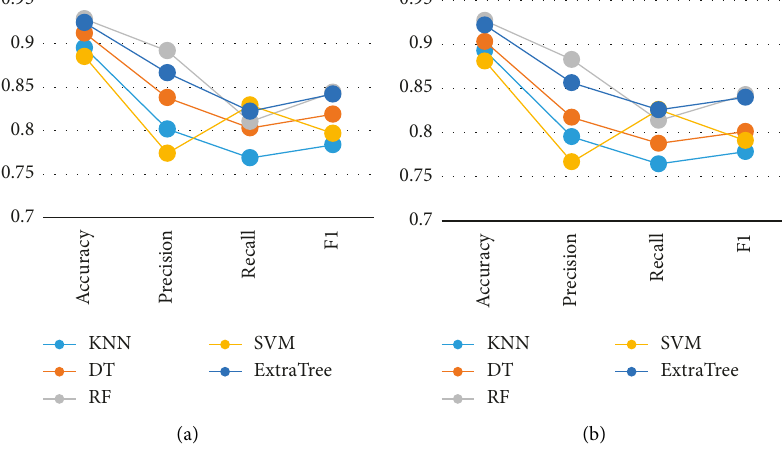
Figure 4: K-fold cross-validation. (a) 10-Fold presentation. (b) 5-Fold presentation.